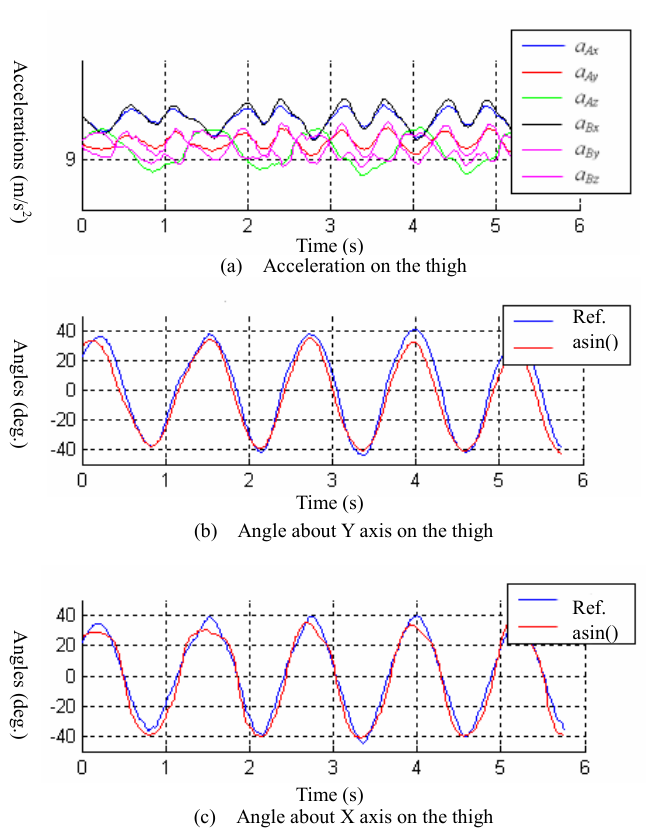
Fig.11 Experiment data from the prototype of the wearable sensor system, where Ref. meas the angle obtained from the high-accuracy camera system, asin() is the angle calculated by